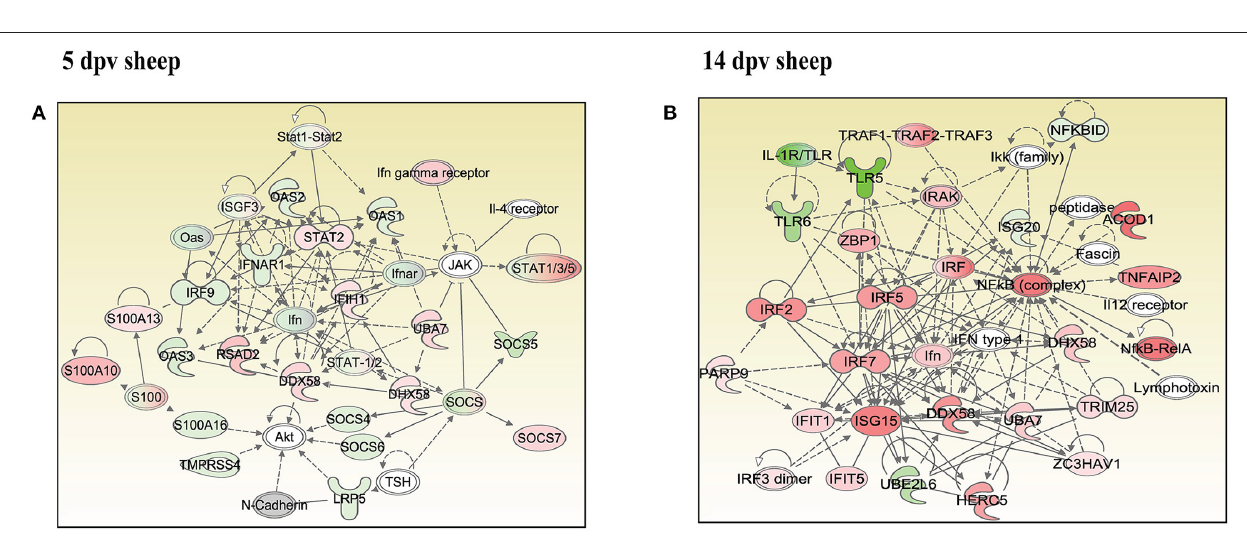
FIGURE 6 | Network generated in Ingenuity Pathway Analysis tool of “infectious diseases, antimicrobial response, and inflammatory response” of differentially expressed proteins (DEPs) in vaccinated sheep at (A) 5 days post-vaccination (dpv) and (B) 14 dpv. Proteins that were upregulated are shown in red, and those that were downregulated are shown in green. Proteins in white were not significantly dysregulated. Symbol shape indicates gene